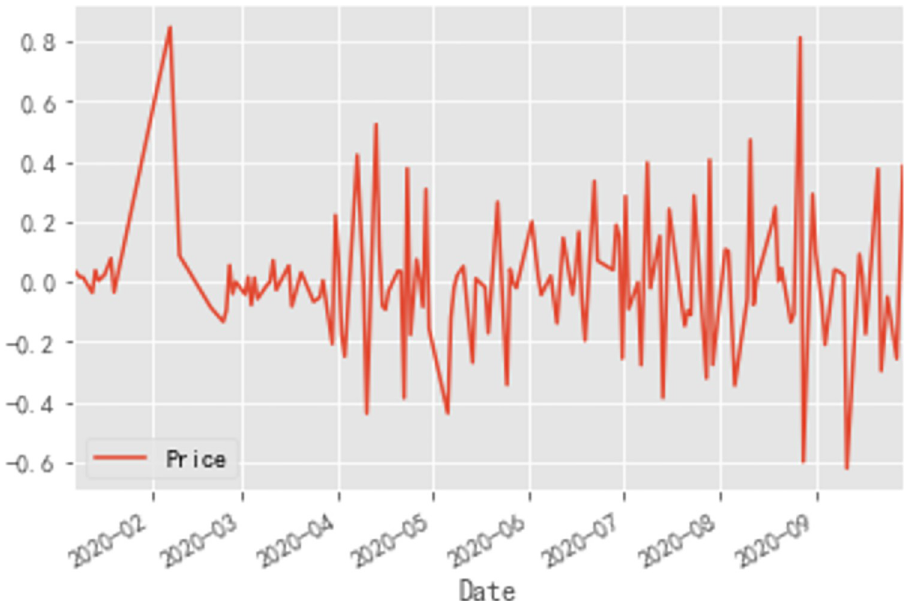
Fig 14. First-order difference time series diagram of cabbage